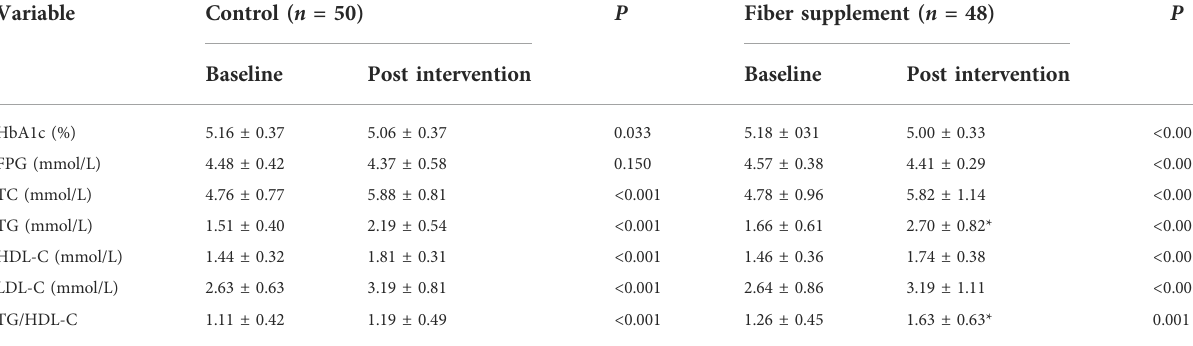
TABLE 2 Glucose and lipids levels in overweight/obese mothers in fi ber supplement and control groups pre and post-intervention.